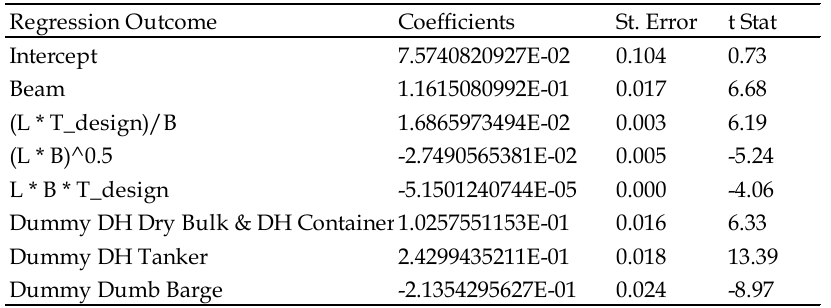
Supporting model to estimate the empty draft of inland ships